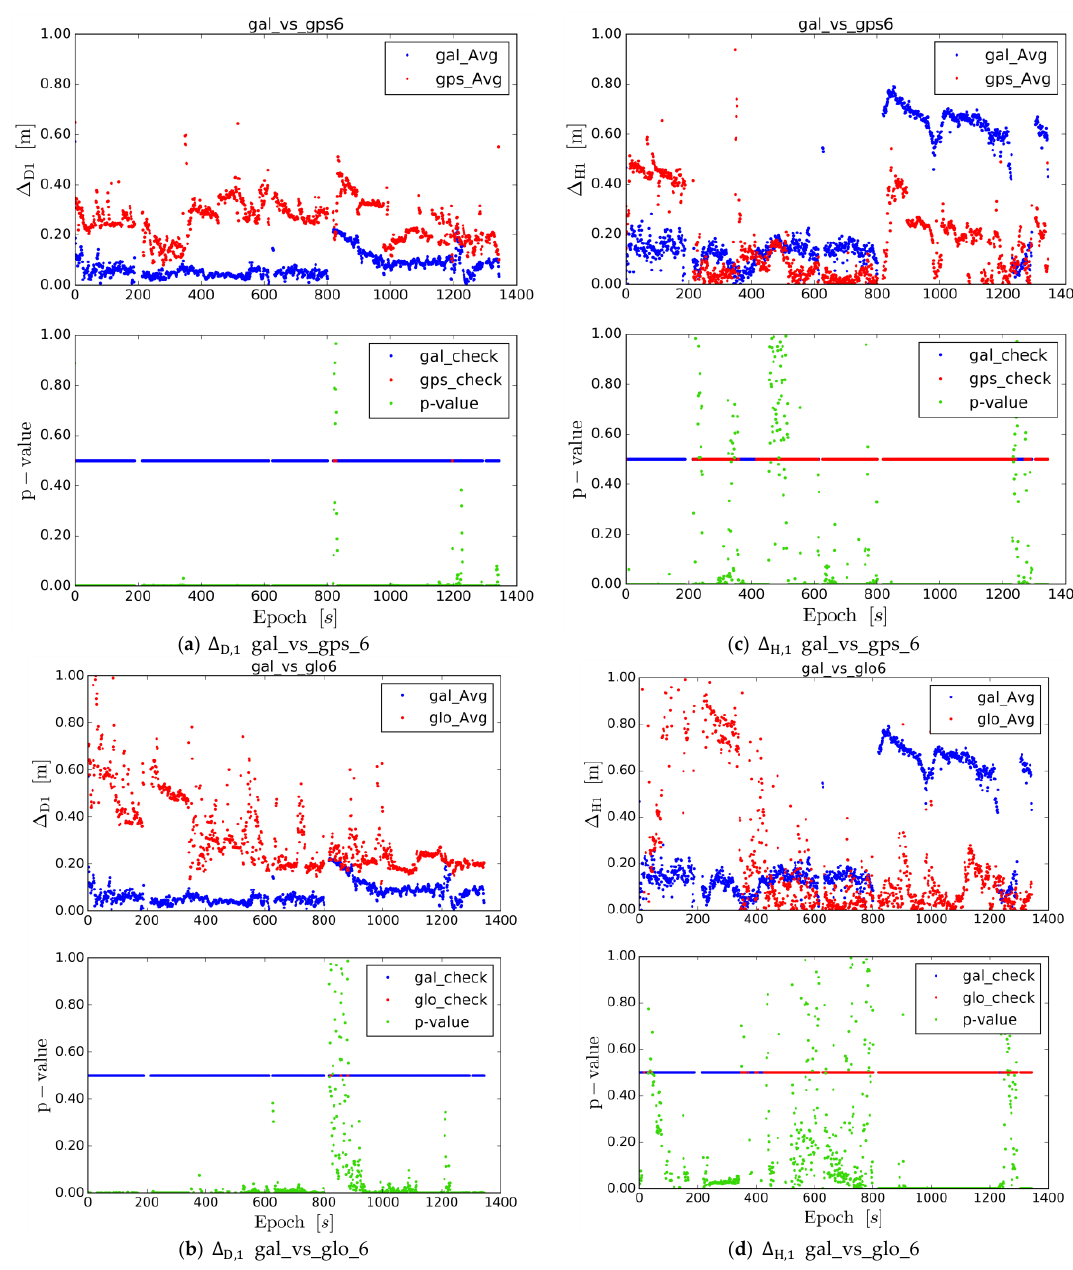
Figure A1. Visual output of the performed test: ( a ) ∆ D,1 gal_vs_gps_6, for Galileo and GPS comparison considering all the fixed solutions (1 in the subscript) for the ∆ D parameter with six considered satellites; ( b ) ∆ D,1 gal_vs_glo_6, for Galileo and GLONASS comparison considering all the fixed solutions (1 in the subscript) for the ∆ D parameter with six considered satellites; ( c ) ∆ H,1 gal_vs_gps_6, for Galileo and GPS comparison considering all the fixed solutions (1 in the subscript), for the ∆ H parameter with six considered satellites; ( d ) ∆ H,1 gal_vs_glo_6, for Galileo and GPS comparison considering all the fixed solutions (1 in the subscript) for the ∆ H parameter with six considered